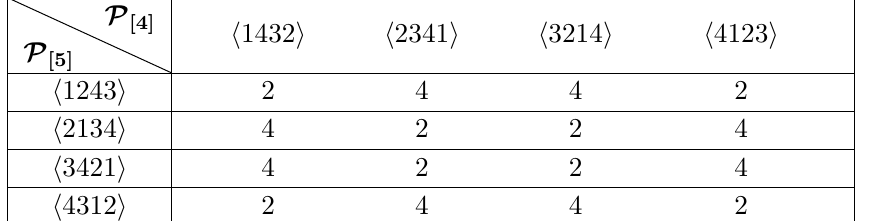
Table 15. {P} 5 − {P} 4 two-point correlator values.